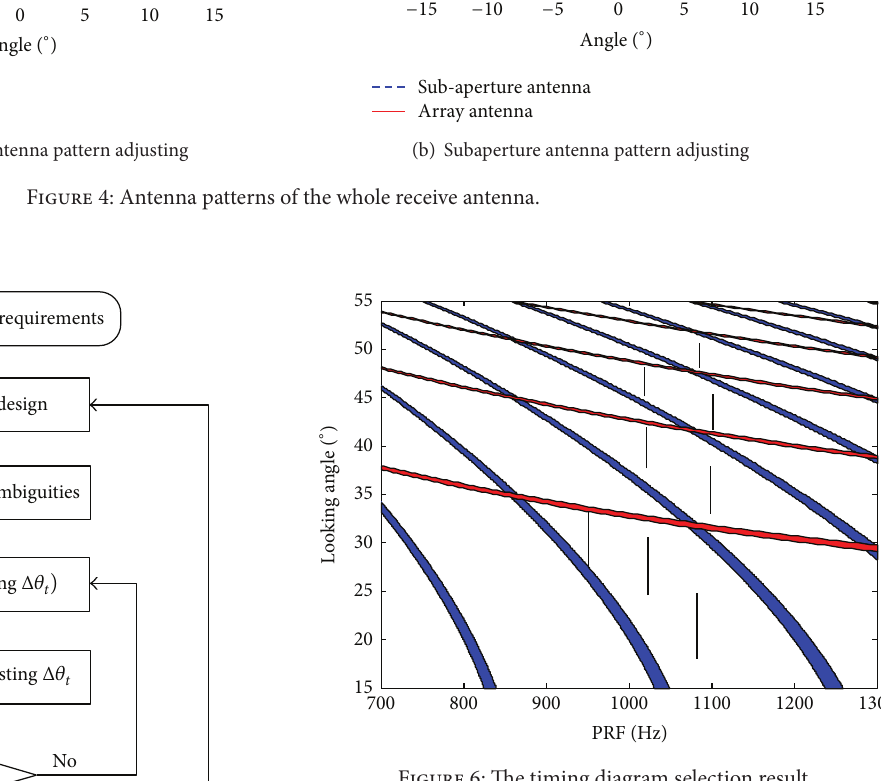
Figure 6: The timing diagram selection